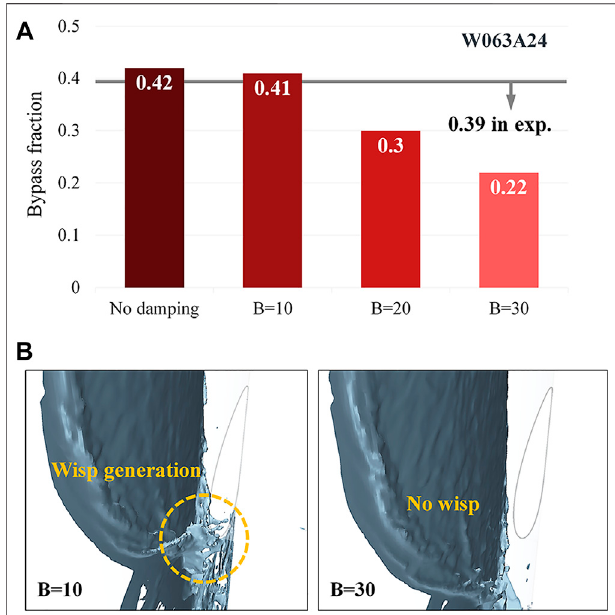
Figure 10 shows the variation in the ECC bypass fraction with the droplet diameter. The bypass fraction was obtained from the water injection rate and the water fl ow rate to the broken cold leg, as follows.